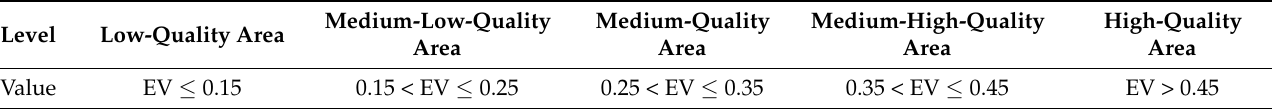
Table 2. Eco-environmental quality index